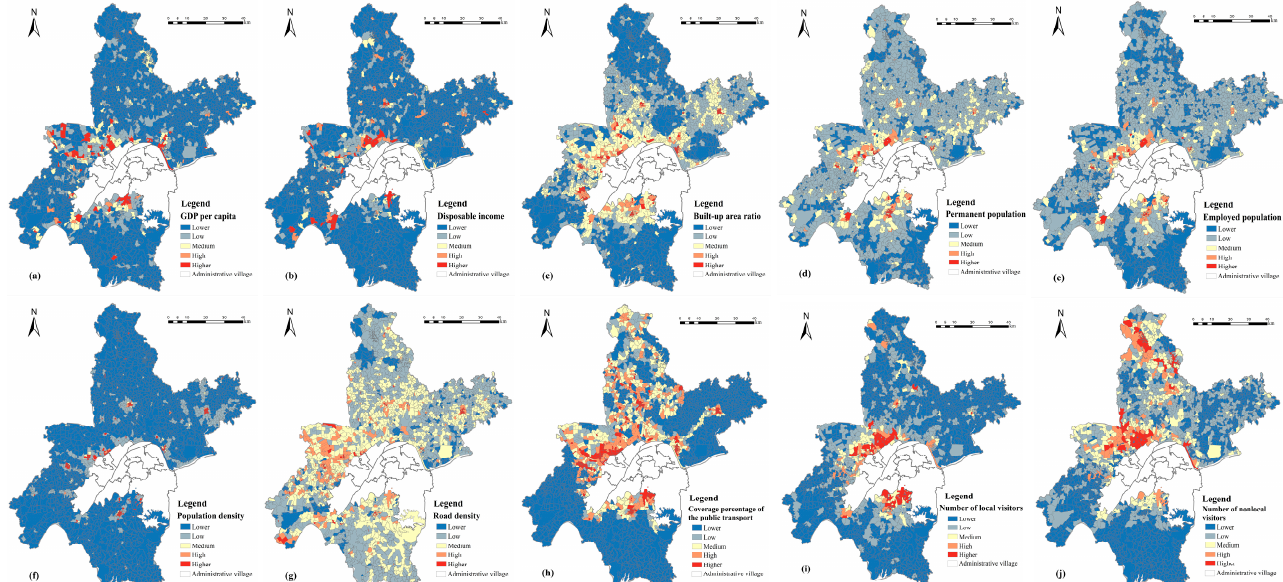
Figure 8. Distribution of influencing factors in Wuhan city’s new urban districts: ( a ) GDP per capita; ( b ) disposable income; ( c ) built-up area ratio; ( d ) permanent population; ( e ) employed population; ( f ) population density; ( g ) road density; ( h ) coverage percentage of the public transport; ( i ) number of local visitors; ( j ) number of nonlocal visitors.